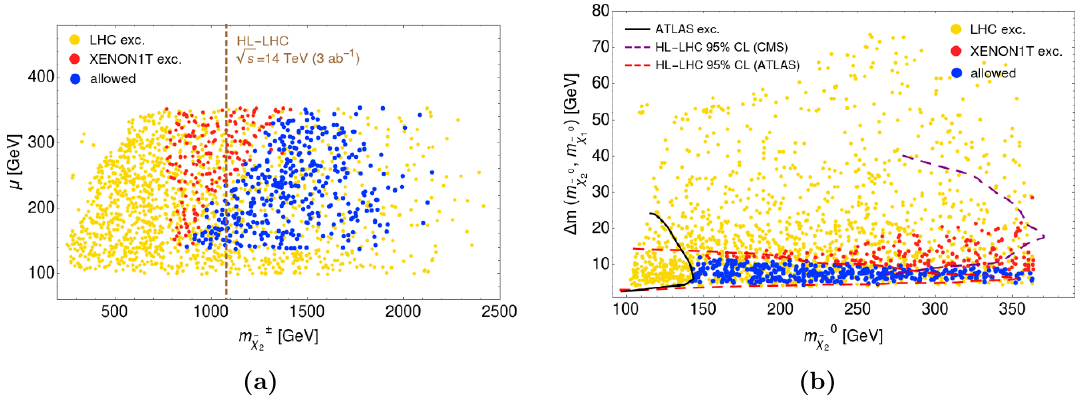
Figure 8. Locus of n = 1 landscape scan points for the NUHM3 model with (cid:22) = 100{360 GeV in the (a) (cid:22) vs. m and (b) m (cid:0) m vs. m planes versus projected HL-LHC 95% CL search (cid:6) e (cid:31) 0 2 e (cid:31) 0 1 e (cid:31) 0 2 e (cid:31) 2